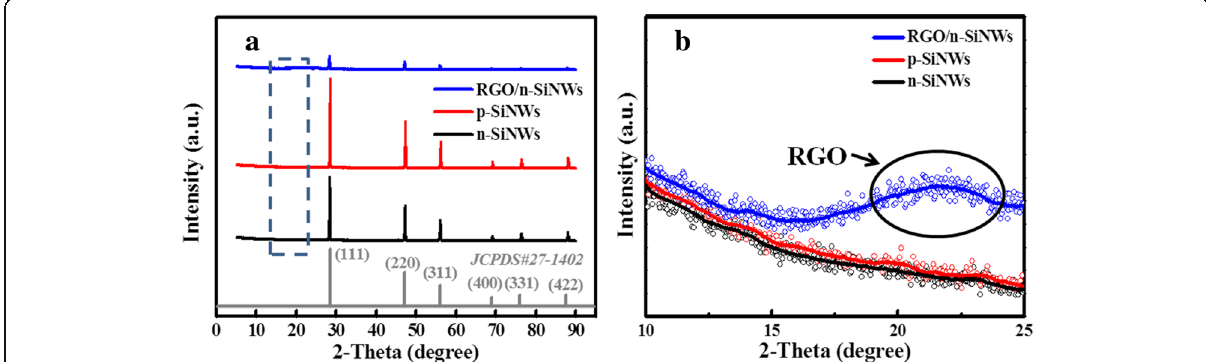
Fig. 2 a XRD patterns of n-/p-SiNWs and RGO@n-SiNWs. b Zoomed-in XRD patterns from 10 to 25